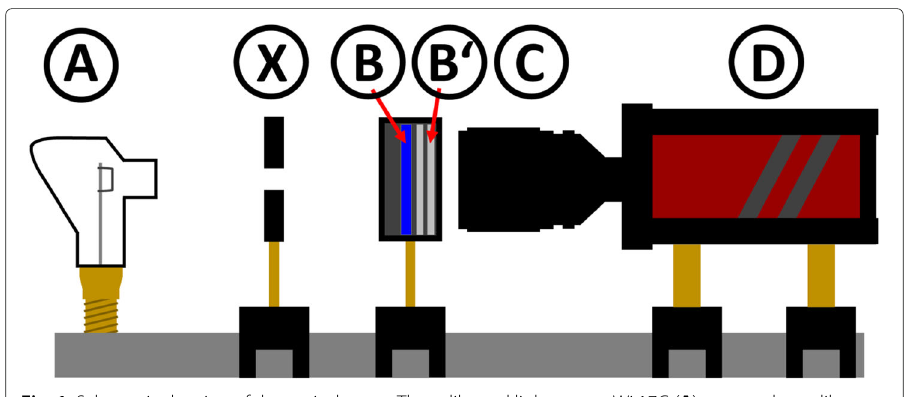
Fig. 1 Schematic drawing of the optical setup. The calibrated light source Wi 17G ( A ) was used to calibrate the sensitivity of the detection system consisting of a lens ( C ) and a camera ( D ). The wavelength of the measurement was determined by an optical bandpass filter ( B ). The light was attenuated by up to two neutral density filters ( B’ ). The solid angle of the imaging optics was measured with a 10.0mm diameter aperture ( X ) as described in the text. This aperture was removed for all other